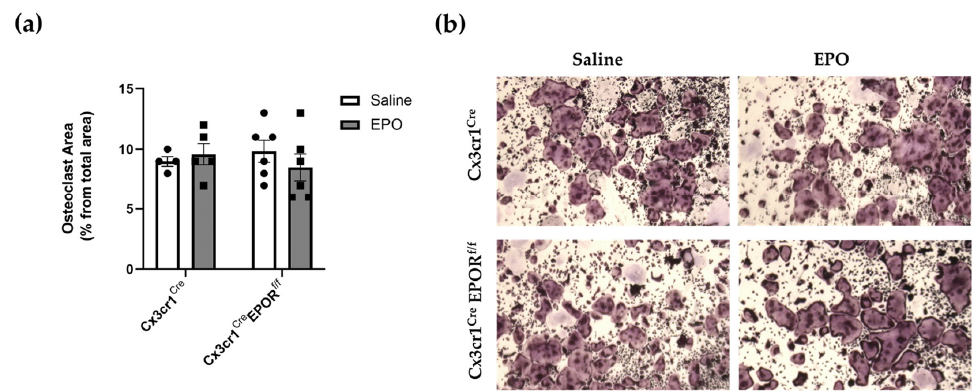
Figure 5. Low-dose EPO does not increase the number of osteoclast progenitors in vivo. ( a ) Female Cx3cr1 Cre EPOR f/f mice and their controls were treated with either saline or EPO (60 IU ×3 per week for 2 weeks). Non-adherent bone marrow cells were grown ex vivo with M-CSF and RANKL, and the total area of multinucleated TRAP + osteoclasts was measured after 6 days as a surrogate for the number of osteoclast precursors in vivo. ( b ) Representative images acquired at × 2 magnification. n = 4 – 6 in each group. All data are mean ± SEM. p values were calculated by 2-way ANOVA. 2.6. LysM Cre Mediates the Conditional Deletion of EPOR in Preosteoclasts Because of the non-significant differences in the response to EPO between control and Cx3cr1 Cre EPOR f/f mice and the mild skeletal response to low-dose EPO, we employed the well-established LysM Cre -induced conditional knockout in the osteoclastic lineage [43– 45] and increased the administered dose of EPO 3-fold [18,26]. In this model, the levels of EPOR mRNA in preosteoclast (CD115 + ) cells were ~1.9-fold greater in the control LysM Cre mice than in the CD115 - cells. Our results also confirm a significant knockout (~12.5-fold) in EPOR mRNA levels in the CD115 + cells from the LysM Cre EPOR f/f mice compared to their controls, with no change in EPOR expression in the CD115 - cells (Figure 6).